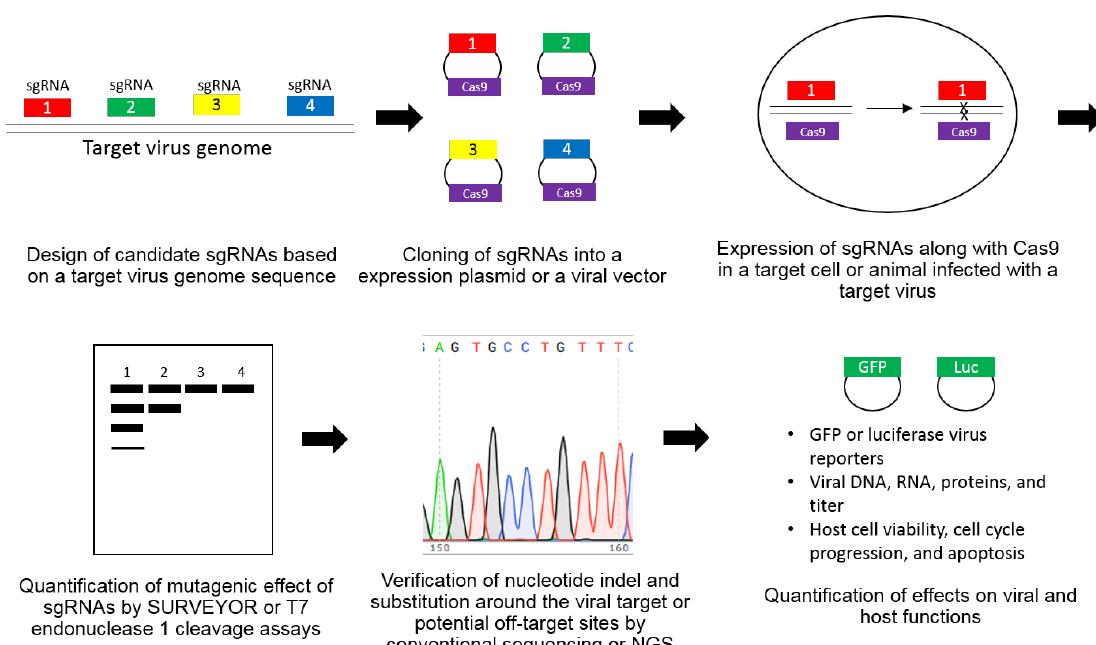
Figure 1. A step-by-step description of a typical CRISPR/Cas9-based antiviral study.